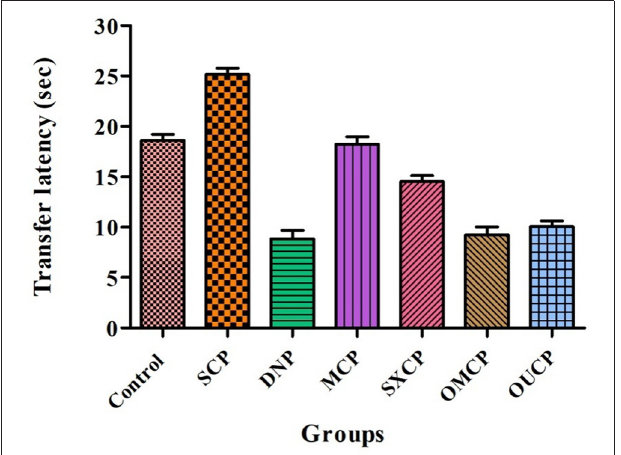
FIGURE 8 | Effects of CP seed extracts on TL. FIGURE 9 | Effects of CP seed extracts on SDL.